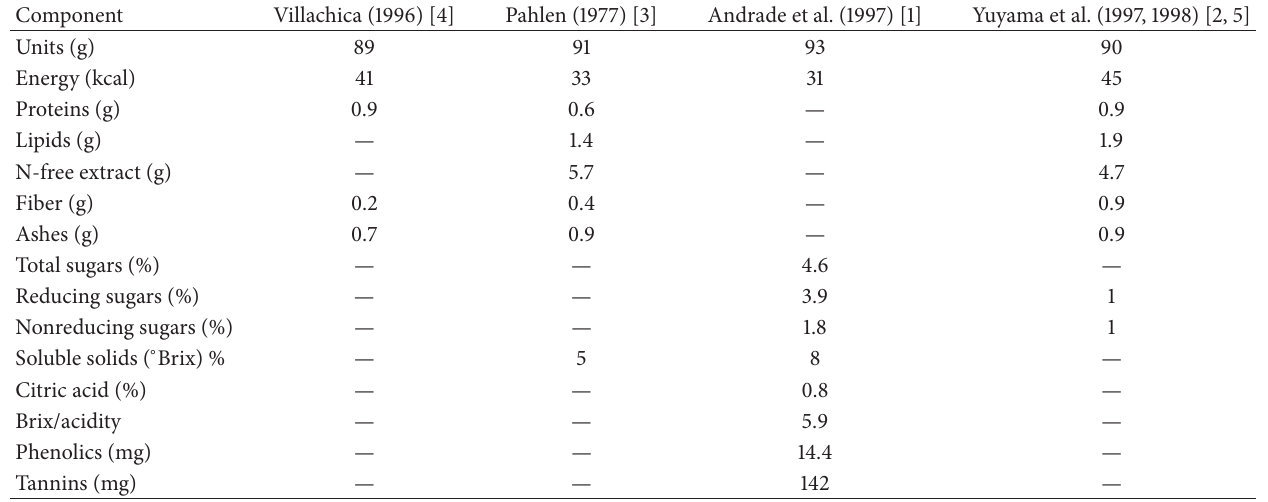
Table 1: Chemical composition of cubiu ( Solanum sessiliflorum ) in 100 g of whole pulp